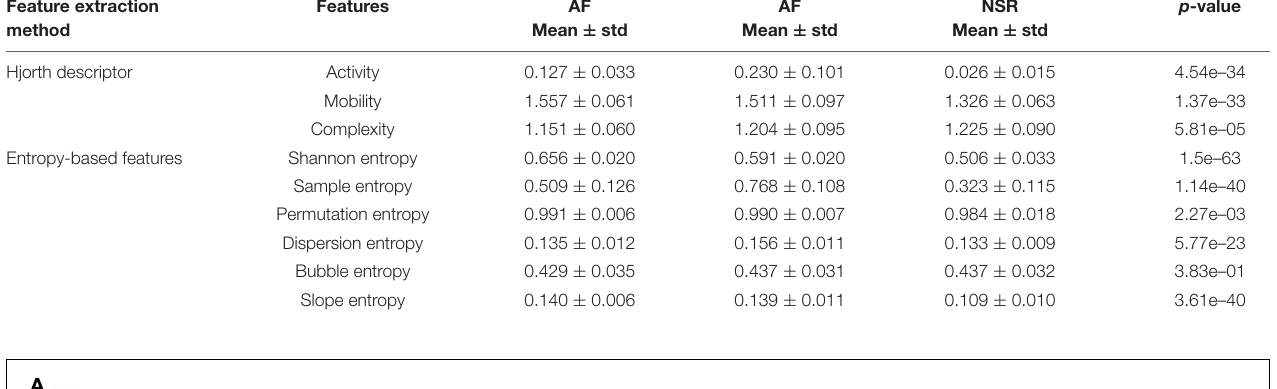
TABLE 1 | Mean and p -values of features for atrial fibrillation (AF), congestive heart failure (CHF), and normal sinus rhythm (NSR) conditions. Feature extraction method